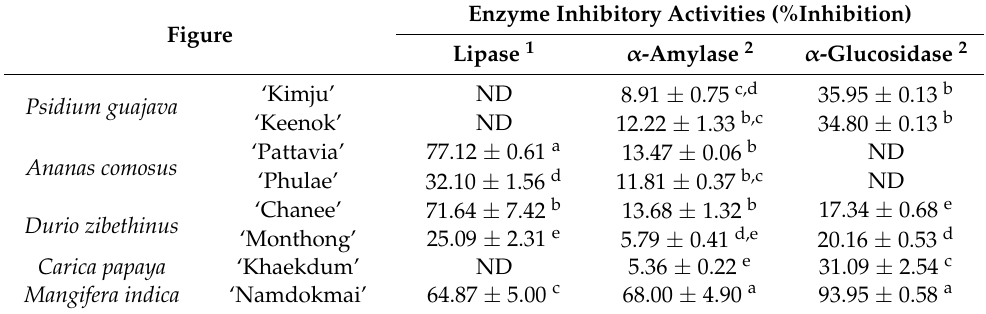
Table 3. Enzyme inhibitory activities of the fruit extracts. Enzyme Inhibitory Activities Figure